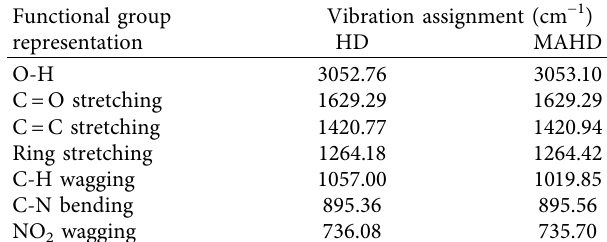
Figure 2: SEM images of oil cell glands of hibiscus flower (a) after pretreatment (soaking for 60min), (b) after MAHD extraction (120min), and (c) after HD extraction (160min). Table 1: Details of hibiscus flower oil functional groups derived from HD and